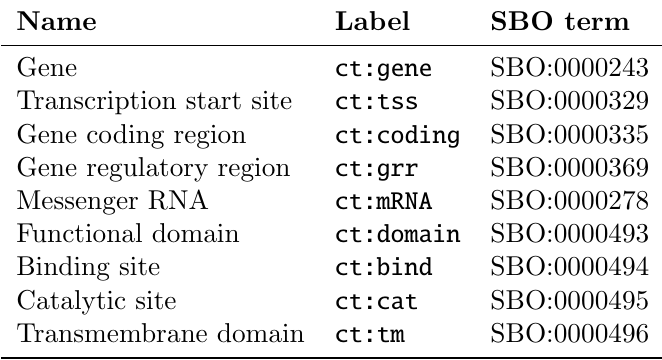
Table 2.2: A sample of values from the conceptual types vocabulary (Section